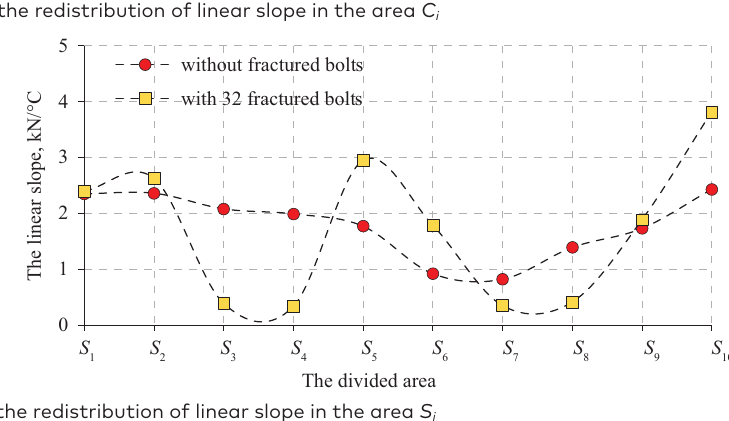
Figure 20. The redistribution of linear slopes caused by 32 fractured bolts